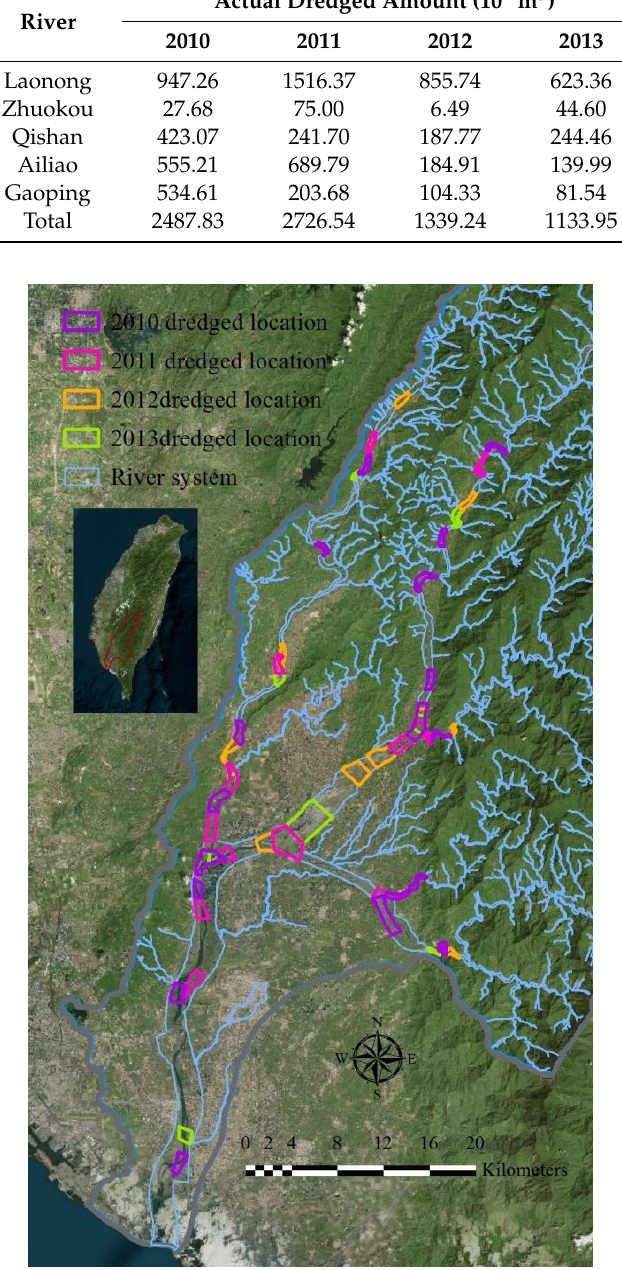
Figure 21. Dredged locations in Gaoping River basin from 2010 to 2013. Table 4. Increase in volume of estimated sediment deposition under baseline (1980–1999) and A1B-S